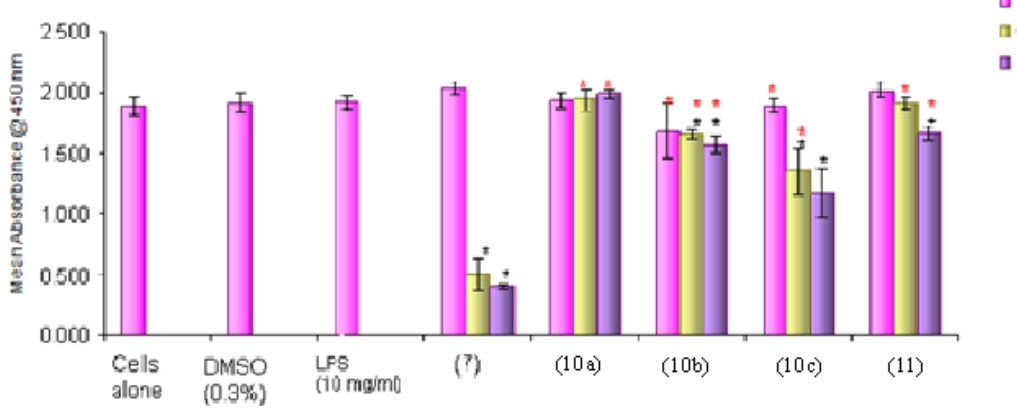
Figure 5. The effects of curcumin ( 7 ) and thiophene curcuminoids 10a – c , 11 on the viability of CACO-2 cells as determined by the MTS assay. Results are presented as mean ± SD. * p < 0.05 compared with DMSO control, * p > 0.05 compared with curcumin control ( 7